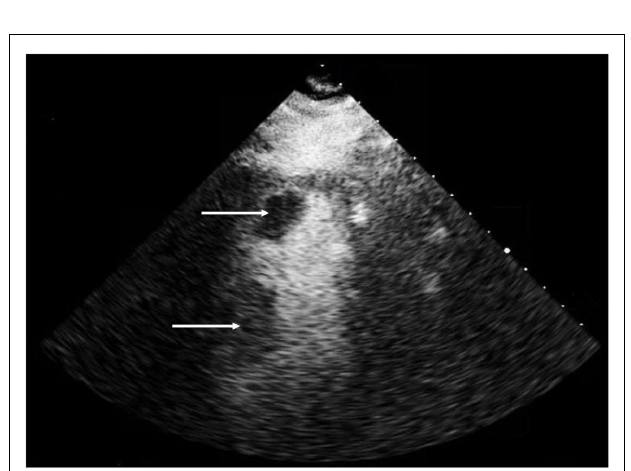
FIGURE 1 | Magnetic resonance imaging brain axial diffusion weighted images demonstrating areas of restricted diffusion in the R occipital lobe (A) and left superior frontal lobe (B) .